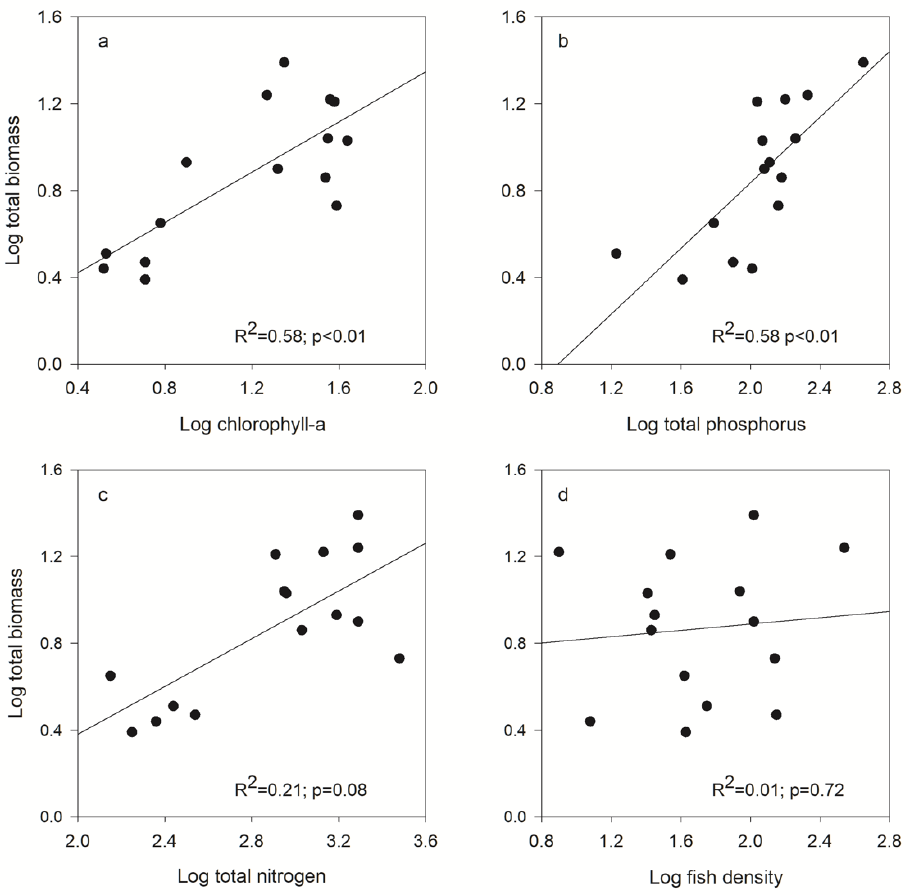
Figure 7. Association of the zooplankton total biomass with ( a ) chlorophyll- a , ( b ) total phosphorus, ( c ) total nitrogen, and ( d ) fish density. All data were log (x + 1) transformed prior to analysis. Table 6. Results of linear regression analysis model showing the correlation between zooplankton biomass and abundance and trophic indicators: chlorophyll- a (chl- a ), total phosphorus (TP), total nitrogen (TN), and fish density. Values indicate the correlation coefficient (R 2 ) and p -value; when p values are greater than 0.05, there is no significant relationship between the two variables.